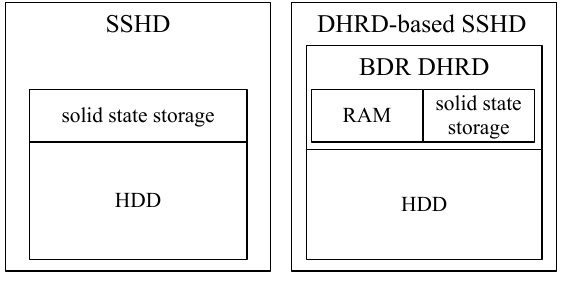
Figure 10. A generic SSHD and a DHRD-based